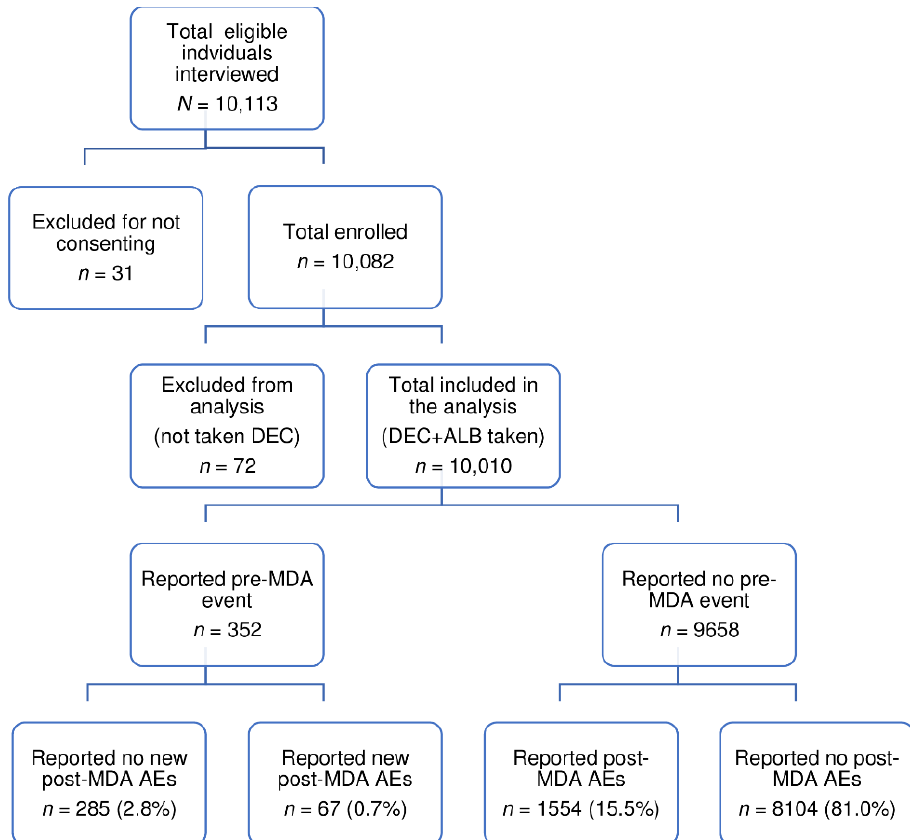
Figure 1. Study flow chart of participant enrolment and follow-up.